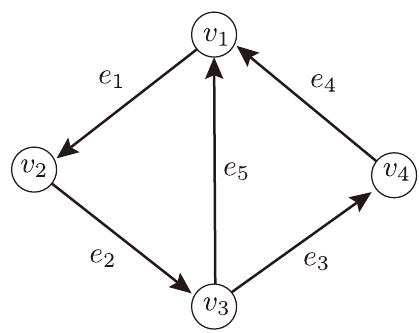
Figure 4. This graph has four vertices and five edges. Two triangles are glued by the edge e 5